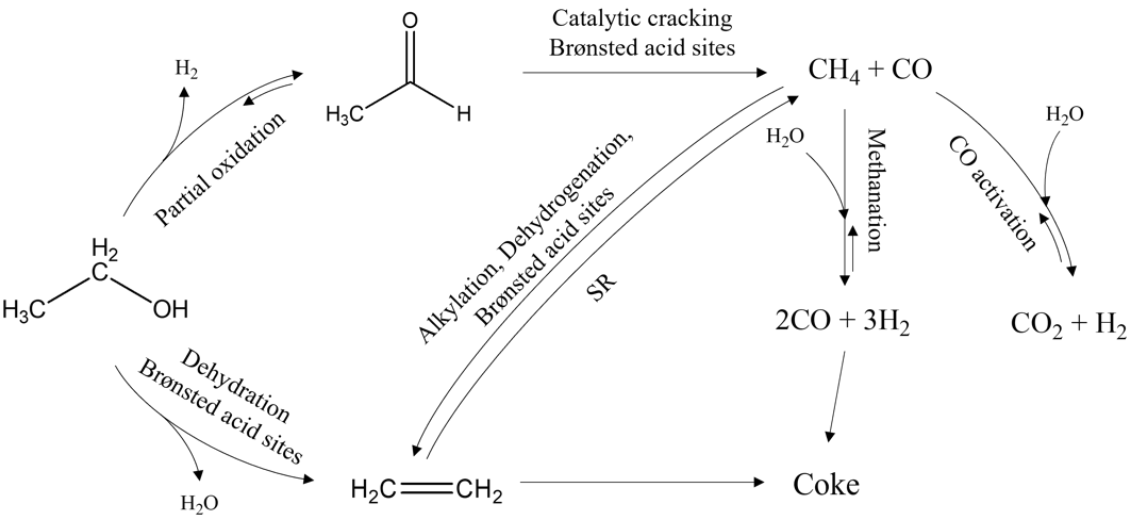
Figure 4. Reactions involved in the ethanol steam reforming and influence of the acid sites (adapted from [64]).